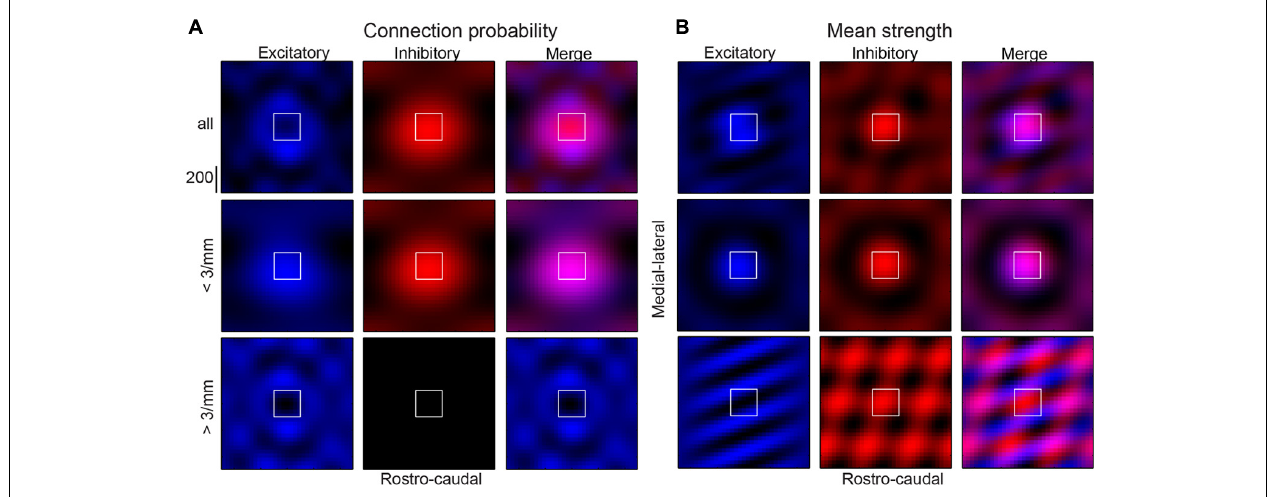
FIGURE 12 | Summary of connection probability (A) and mean strength (B) results demonstrating “average” A1 layer 2/3 neuron (top rows). Inhibitory inputs are in red (left columns), excitatory inputs are in blue (center columns) and both are shown overlaid (right columns). Images were created with inverse 2D FFT of only the significant components for the corresponding maps (pixels in red in connection